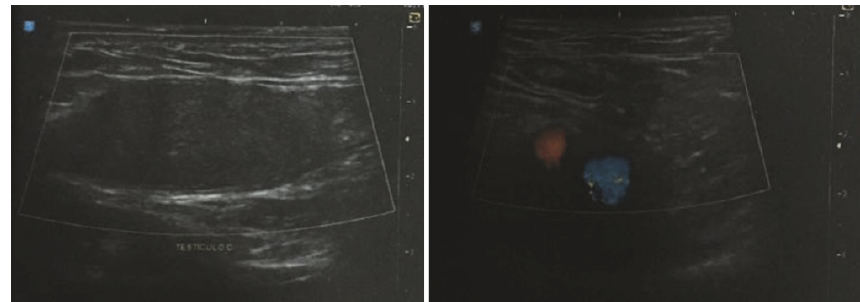
Figure 1: Doppler ultrasound of the right testicle.